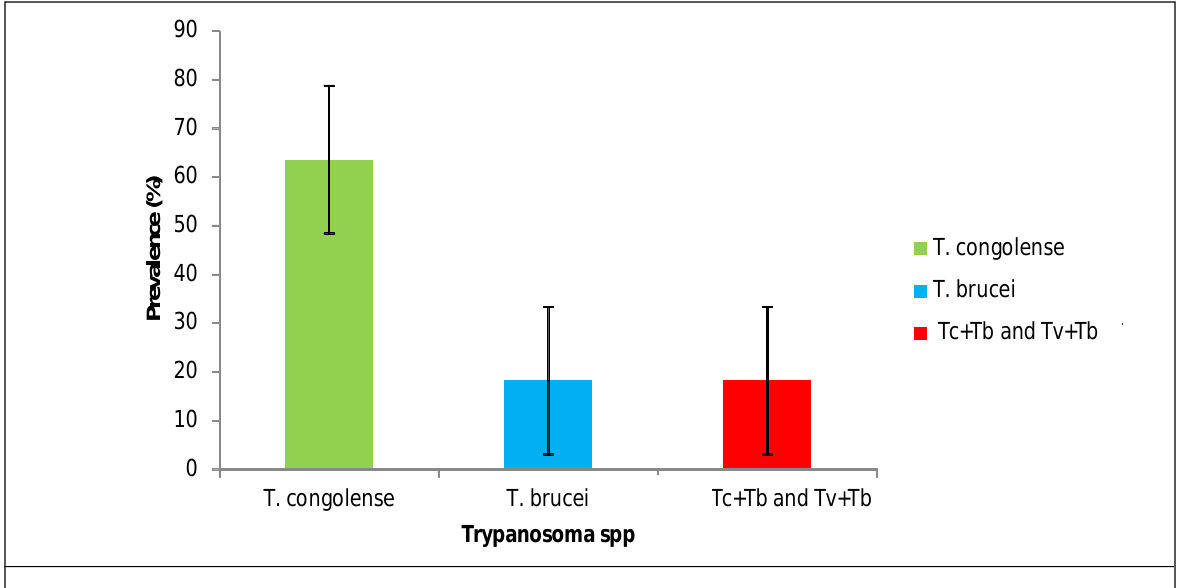
Figure 2: Species specific prevalence of bovine trypanosomiasis